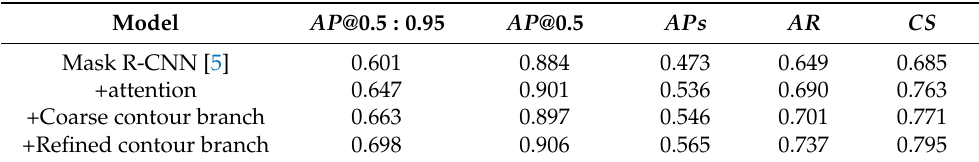
Table 4. Ablation study with different components combinations on the WHU aerial image dataset. The best results are in